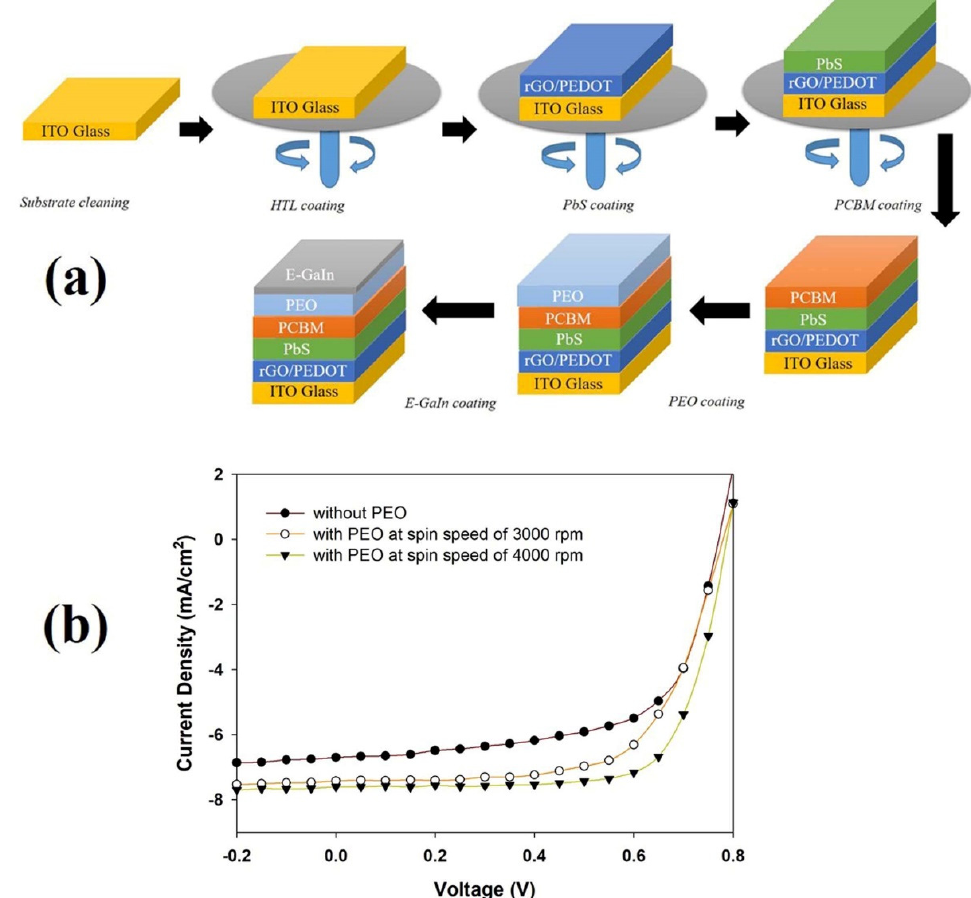
Figure 5. ( a ) Device fabrication process and ( b ) the current density-voltage (J-V) curves of the device without and with the PEO buffer